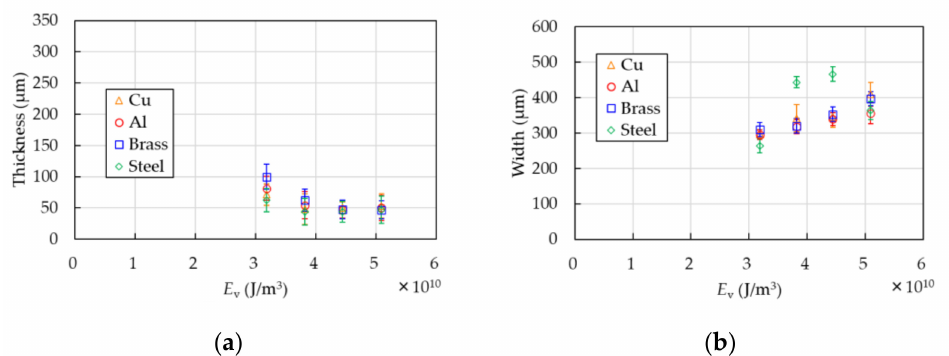
Figure 9. Comparison of the Cu base with that of Al, brass, and steel. Thickness ( a ) and width ( b ) are shown. The thickness is measured with the laser interferometer. The width and error bars in both figures are evaluated with the digital micrometer as well as the above-mentioned